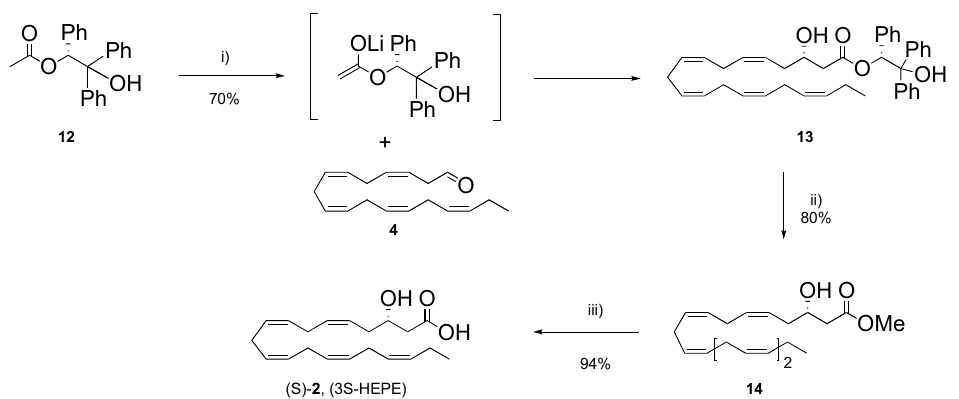
Table 2. Combinations of configurations of 3-hydrocyeicosapentaenoic acids MTBA-esters ( 15 ) and their chemical